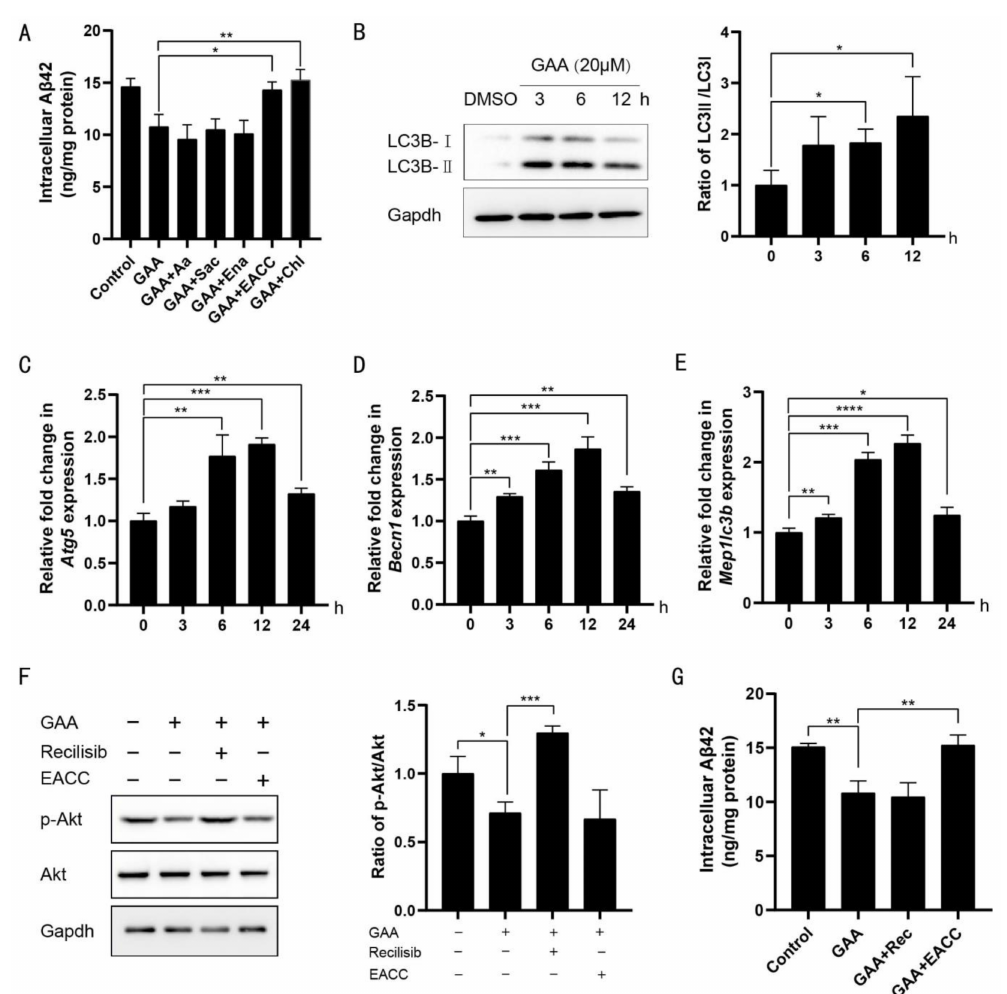
Figure 2. GAA promotes A β 42 elimination through the autophagy pathway in microglial cells. ( A ) BV2 cells were treated with GAA (20 µ M), the indicated antagonists of ADEs (arachidonic acid at 80 µ M, sacubitrilat at 50 µ M, enalapril maleate at 50 µ M), autophagosomes (EACC at 2 µ M) and lysosomes (chloroquine at 20 µ M), in the presence of A β 42 (2 µ M) for 24 h, and intracellular A β 42 levels were measured by ELISA. GAA + EACC vs. GAA: p = 0.0122; GAA + Chl vs. GAA: p = 0.0075; n = 3. ( B ) BV2 cells were treated with GAA (20 µ M) for the indicated periods of time, and whole cell proteins were collected for western blot. 6 h vs. 0 h: p = 0.0219; 12 h vs. 0 h: p = 0.0467; n = 3. ( C – E ) BV2 cells were treated with GAA (20 µ M) for the indicated times, and expression of Atg5, Becn1 and Map1lc3b was analyzed by qRT-PCR. ( C ) 6 h vs. 0 h: p = 0.0075; 12 h vs. 0 h: p = 0.0002; 24 h vs. 0 h: p = 0.0069; n = 3. ( D ) 3 h vs. 0 h: p = 0.0015; 6 h vs. 0 h: p = 0.0007; 12 h vs. 0 h: p =